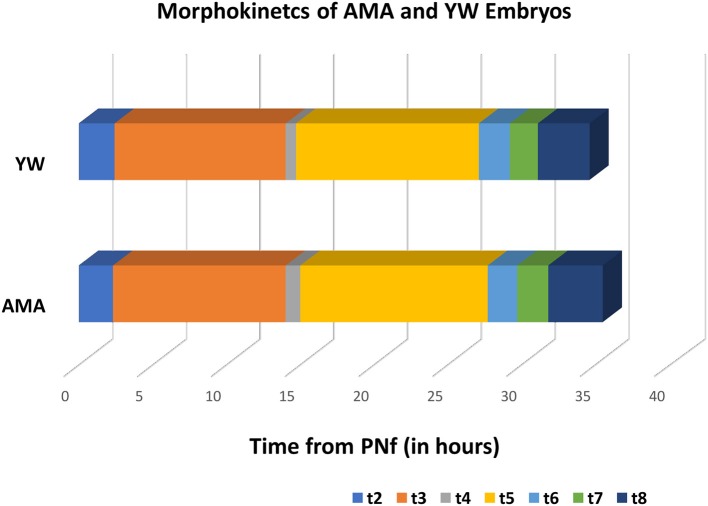
A comparison of the morphokinetic parameters of AMA and YW embryos.